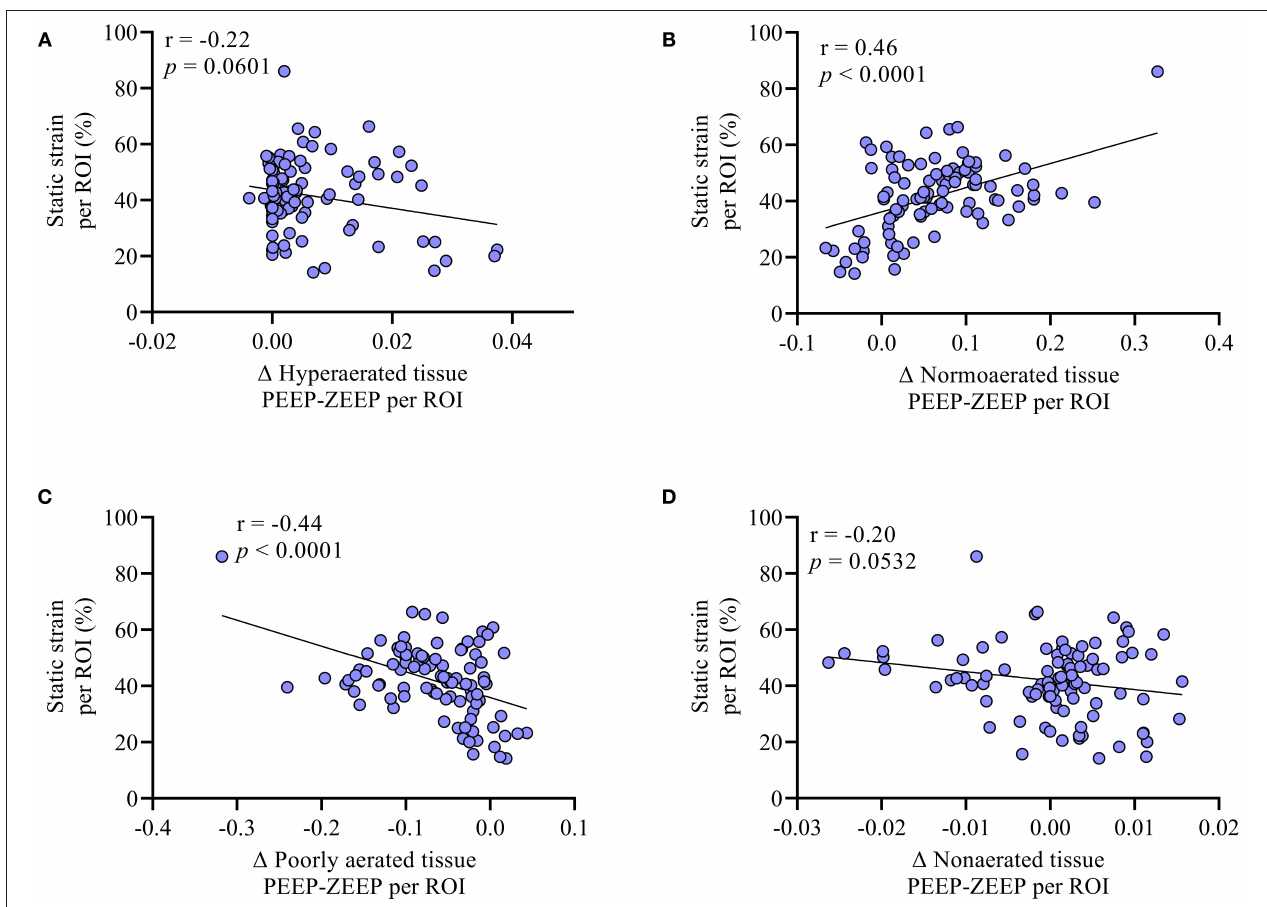
FIGURE 7 | The association between the difference in (A) hyperaerated ( 1 hyperaerated tissue PEEP-ZEEP), (B) normoaerated ( 1 normoaerated tissue PEEP-ZEEP), (C) poorly aerated ( 1 poorly aerated tissue PEEP-ZEEP), and (D) non-aerated ( 1 non-aerated tissue PEEP-ZEEP) tissue between PEEP and PEEP and the static strain measured at the ROI level was evaluated with correlation. No significant correlations were found between the change in hyperaeration and non-aeration when adding PEEP and the generation of static strain. Conversely, as shown in (B) , the larger the gain in normoaerated tissue, the larger the static strain induced by PEEP. Similarly, (C) shows that the more the reduction in the poorly aerated tissue, the higher the static strain induced by